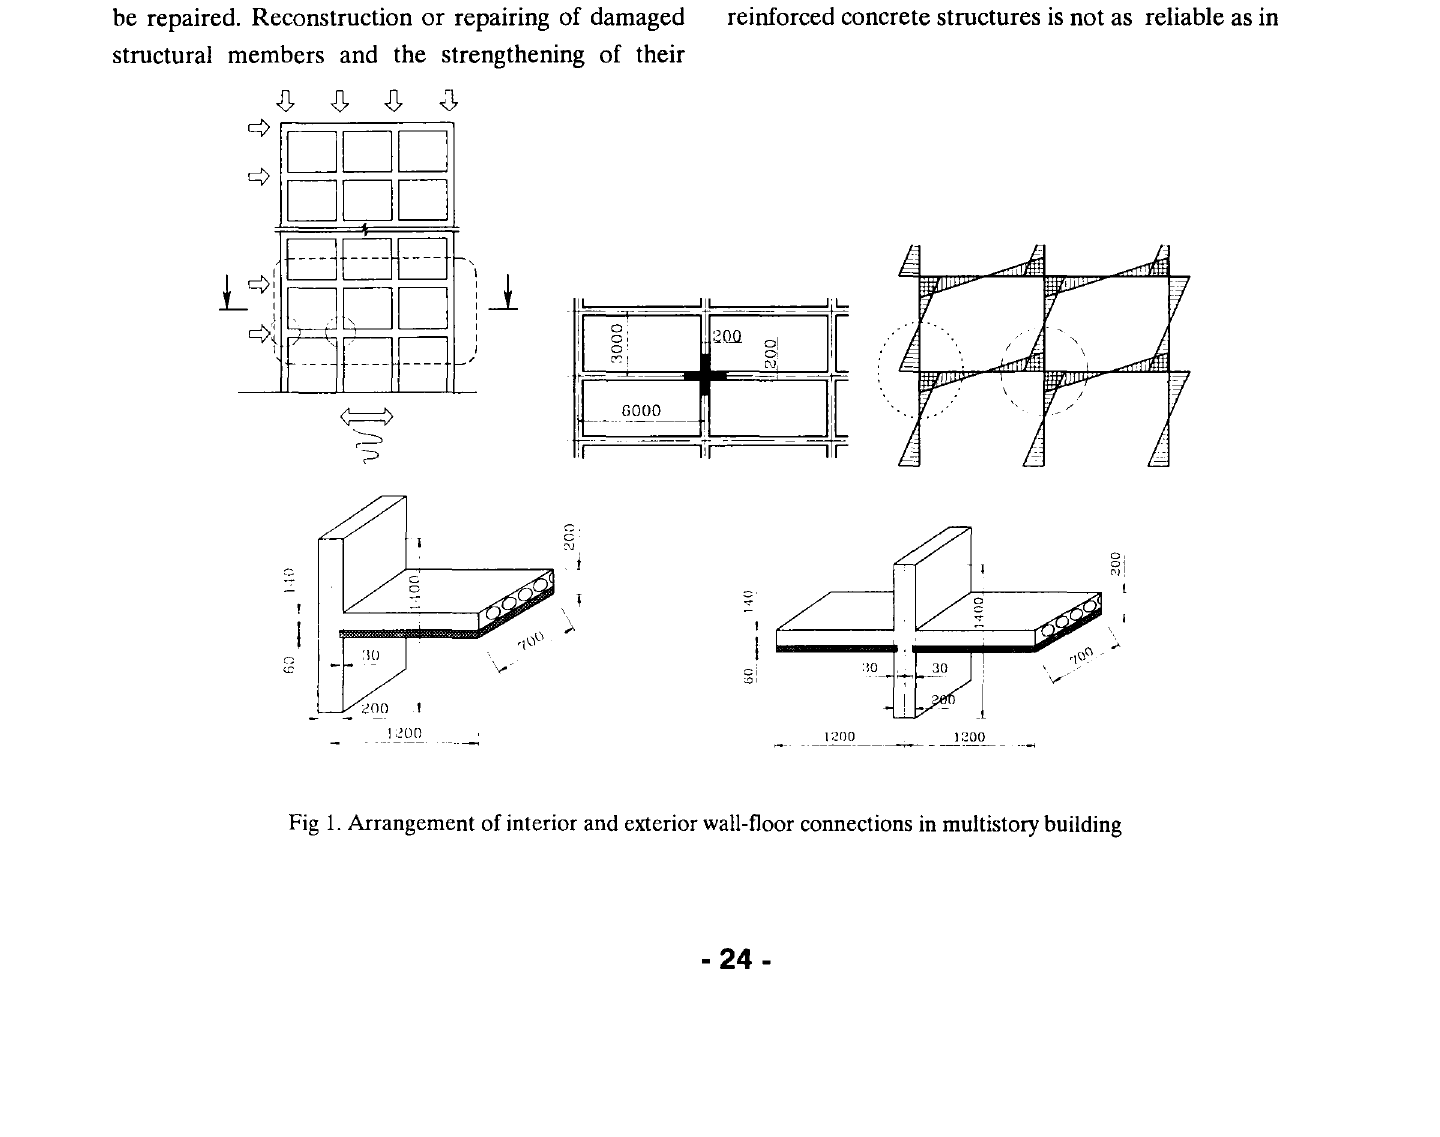
Fig 1. Arrangement of interior and exterior wall-floor connections in multistory